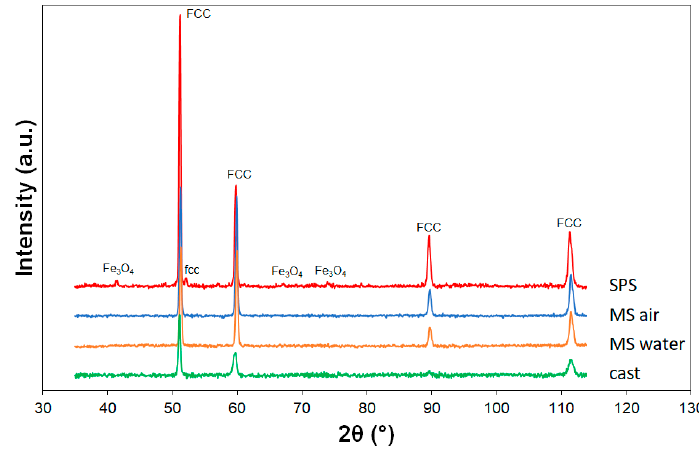
Figure 3. XRD diffraction patterns of CoCrFeMnNi samples.